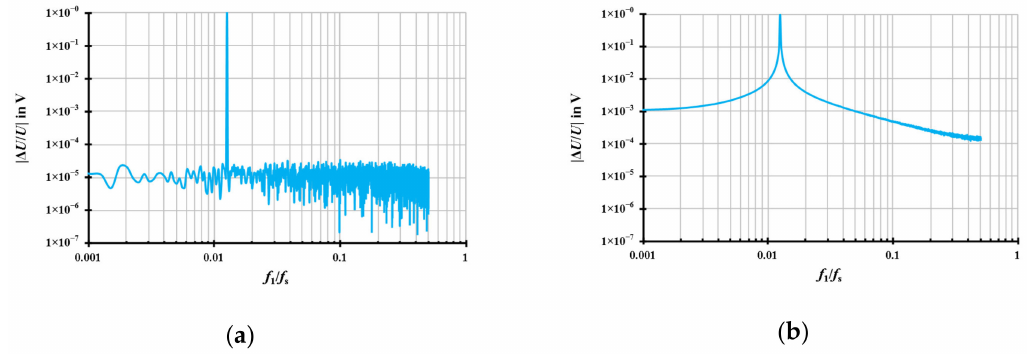
Figure 2. Discrete Fourier Transform (DFT) spectra of the synchronous signal; ( b ) The DFT spectra of the asynchronous signal. The signals are given for f S = 4000 Hz, T W = 1 s, U 1 = 1 V, f 1 = 50.1 Hz, ϕ = 0 ◦ and u = 1 mV without 1 Noise